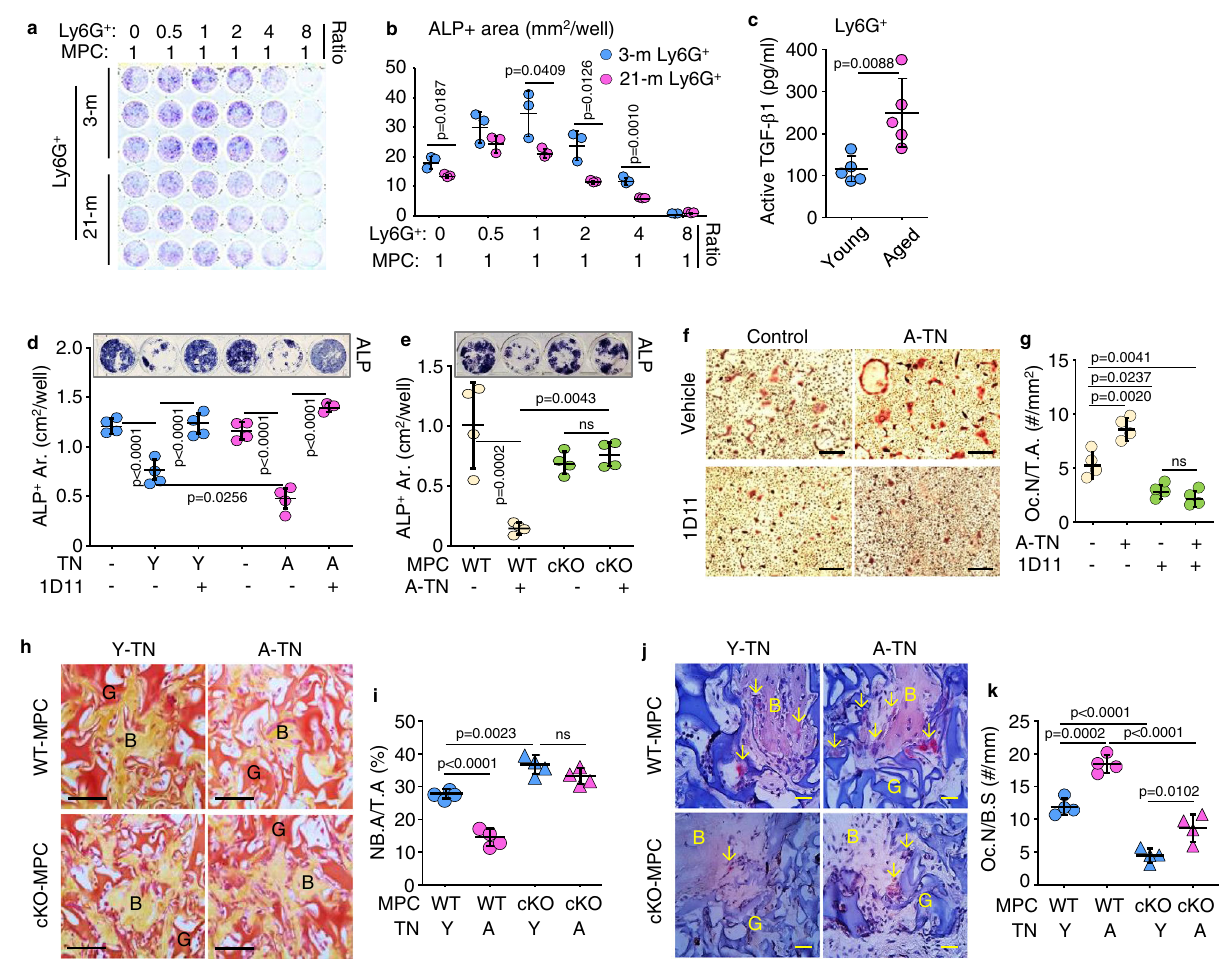
Fig. 2 | Neutrophils inhibit osteoblast differentiation from MPCs and promote osteoclast formation through TGF β . a Mesenchymalprogenitor cells (MPCs) co- cultured with Ly6G + BM cells from 3- and 21-mon-old mice for 4 d and b ALP + OB area. Mean±SD (n =3 biologically independent samples/group). c Active TGF β 1 protein levels in lysates of Ly6G + BM cells magnetically-isolated from 4- and 22- mon-old mice tested using ELISA. Mean±SD ( n =5 biologically independent male mice/group). d MPCs from 3-mon-old C57 mice co-cultured with TGF β 1 + neu- trophils (TNs) sorted from BM of 3- and 20-mon-old C57 mice and treated with vehicle or the TGF β neutralizing Ab, 1D11. ALP staining performed for osteoblast measurement. Mean±SD ( n =4 biologically independent samples/group). e MPCs from TGF β RII fl / fl (WT) and Prx1 Cre ;TGF β RII fl / fl (cKO) male mice co-cultured with TNs sortedfrom20-mon-oldC57mice (A-TN),and ALP + stainedosteoblasts. Mean±SD ( n =4 biologically independent samples/group). f , g Osteoclast precursors from